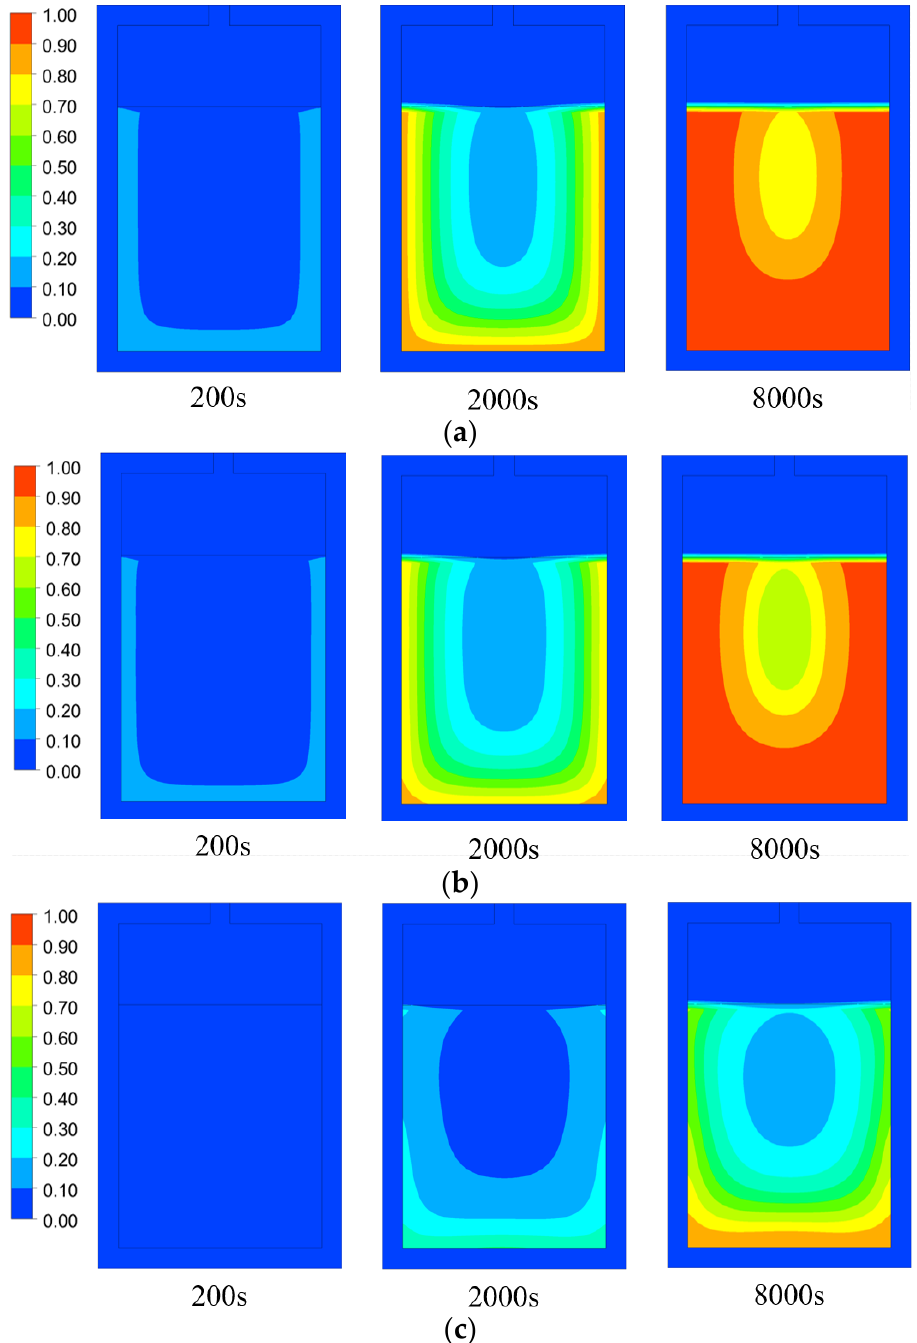
Figure 7. A reacted fraction X distribution cloud figure in different times of the reaction tank selecting air, water, and oil as the heat transfer media: ( a ) water as the heat transfer medium; ( b ) oil as the heat transfer medium; ( c ) air as the heat transfer medium.